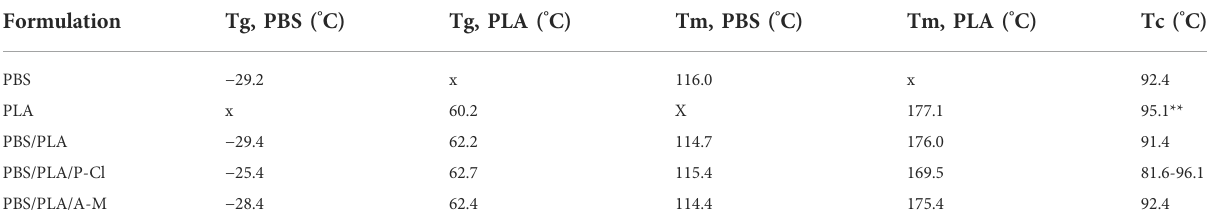
TABLE 5 Glass transition, melting, and crystallization temperatures of PBS, PLA, PBS/PLA (60:40 phr), PBS/PLA/P-Cl and PBS/PLA/A-M (60:40:1 phr) fi lms determined using DSC (second heating/cooling ramp) before exposure. **Hardly visible peak. Formulation